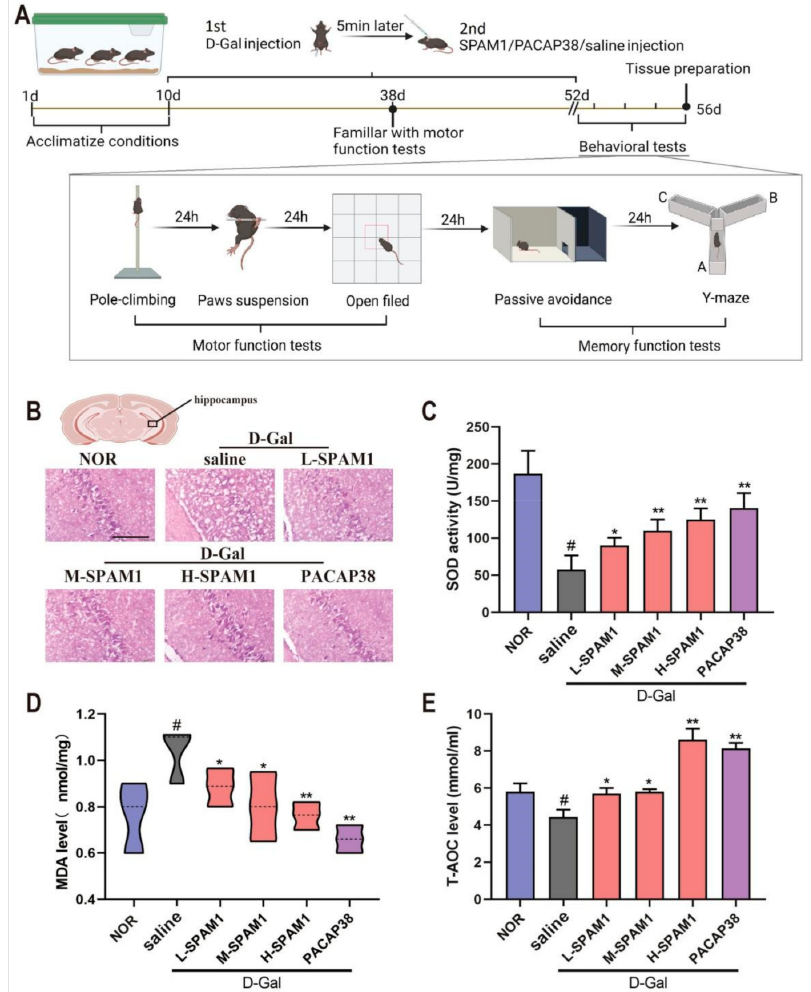
Figure 4. Effect of SPAM1 on antioxidative status of D-gal aging mouse brain. ( A ) The mouse D-gal aging model was firstly subjected to the treatment with L-SMAP1 (10 µ mol/kg/day), M-SMAP1 (40 µ mol/kg/day, H-SMAP1 (100 µ mol/kg/day) and PACAP3 (100 nmol/kg/day), respectively, and then submitted to motor function and memory function test procedure; ( B ) HE staining showed